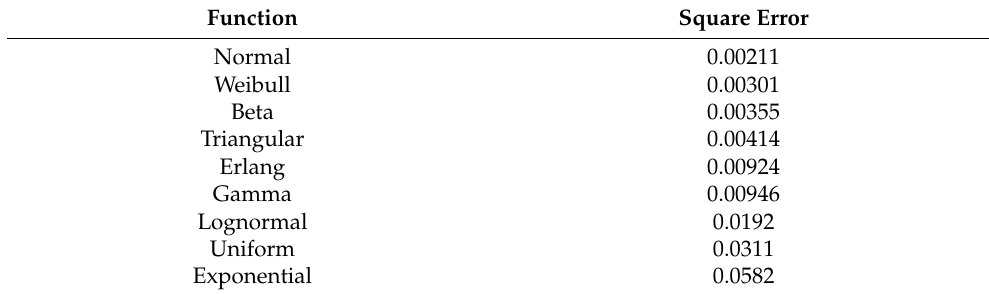
Table 1. Shovel 1 payload square errors for the functions tested with Arena Input Analyzer.